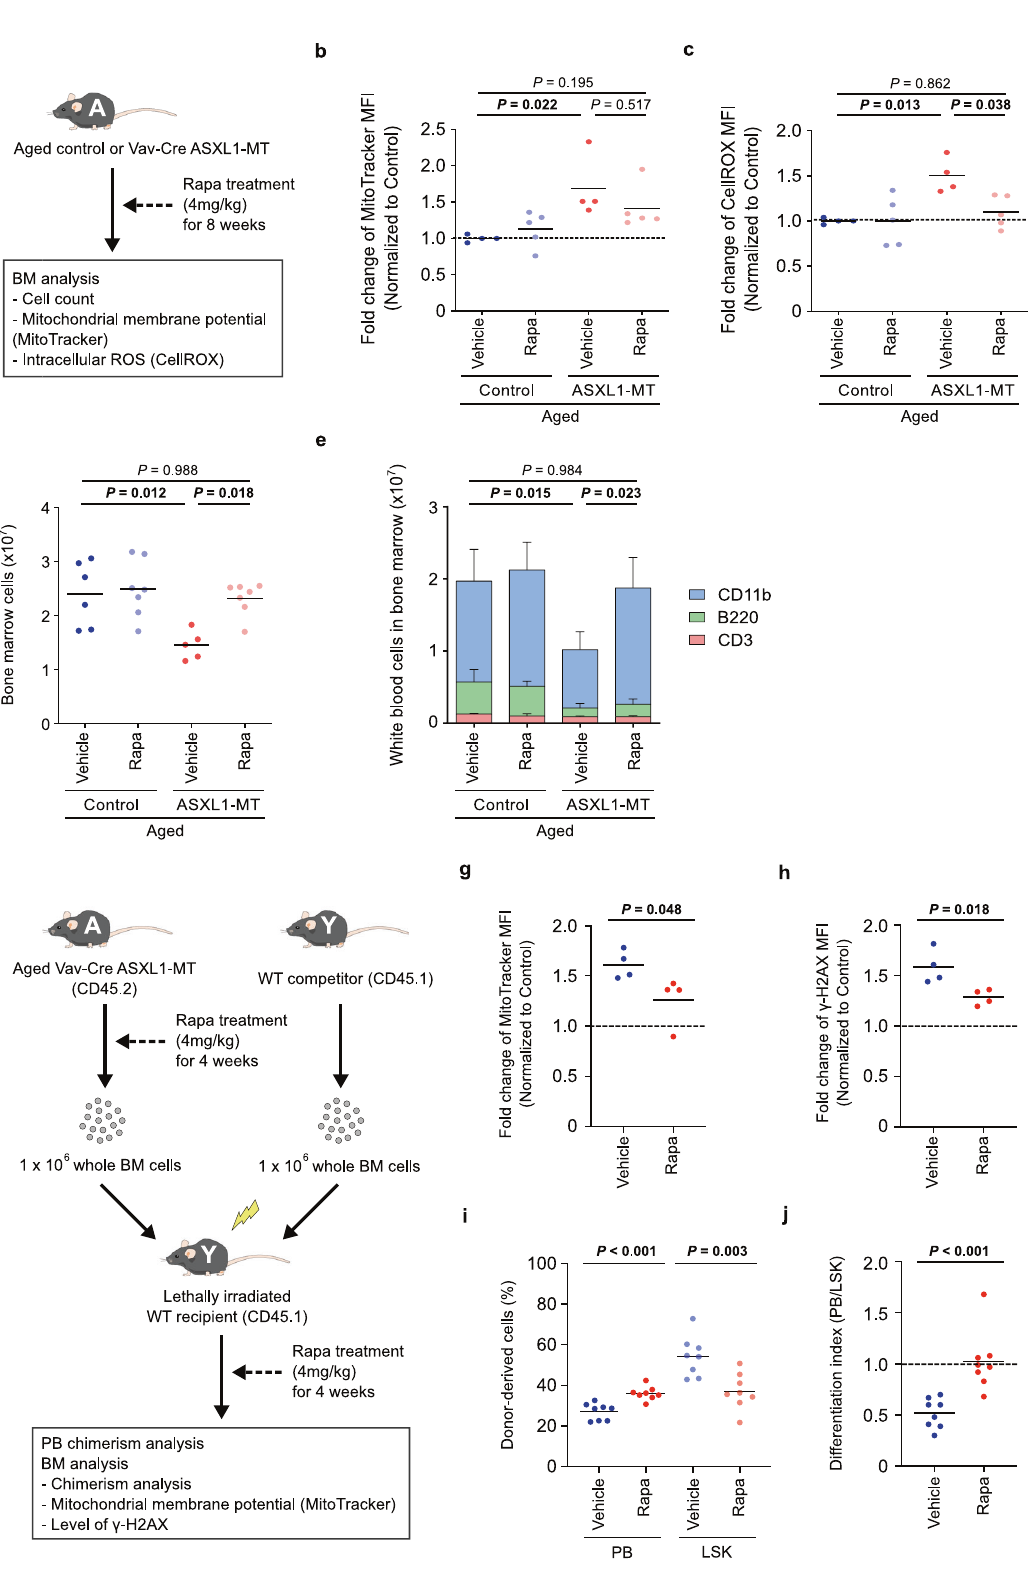
Gene set enrichment analysis (GSEA) was performed using the GSEA tool from the Broad Institute (http://software.broadinstitute.org/gsea/). Heat maps were gener- ated using heatmap.2 function of gplots package (3.0.4), from the Bioconductor. The microarray data for HSCs of young and aged wild-type mice are publically available at Gene Expression Omnibus (GEO) with the reference series tag “ GSE 48893 ”